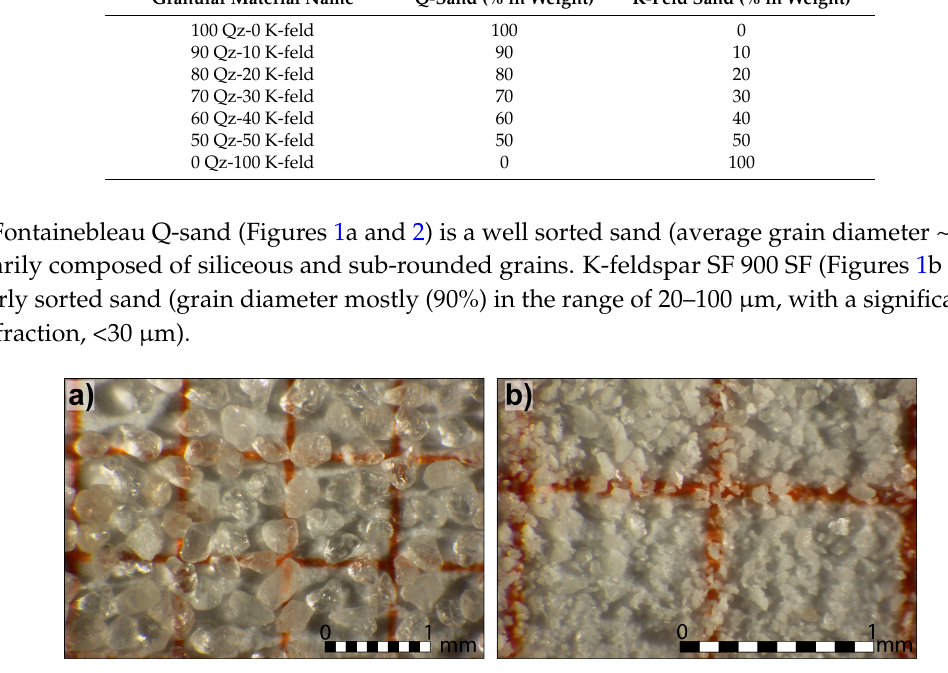
Figure 1. Microscope picture of the pure Q-sand ( a ) and pure K-feldspar sand ( b ). Note the strong differences in terms of grain size, grain size distribution, and grain roundness.